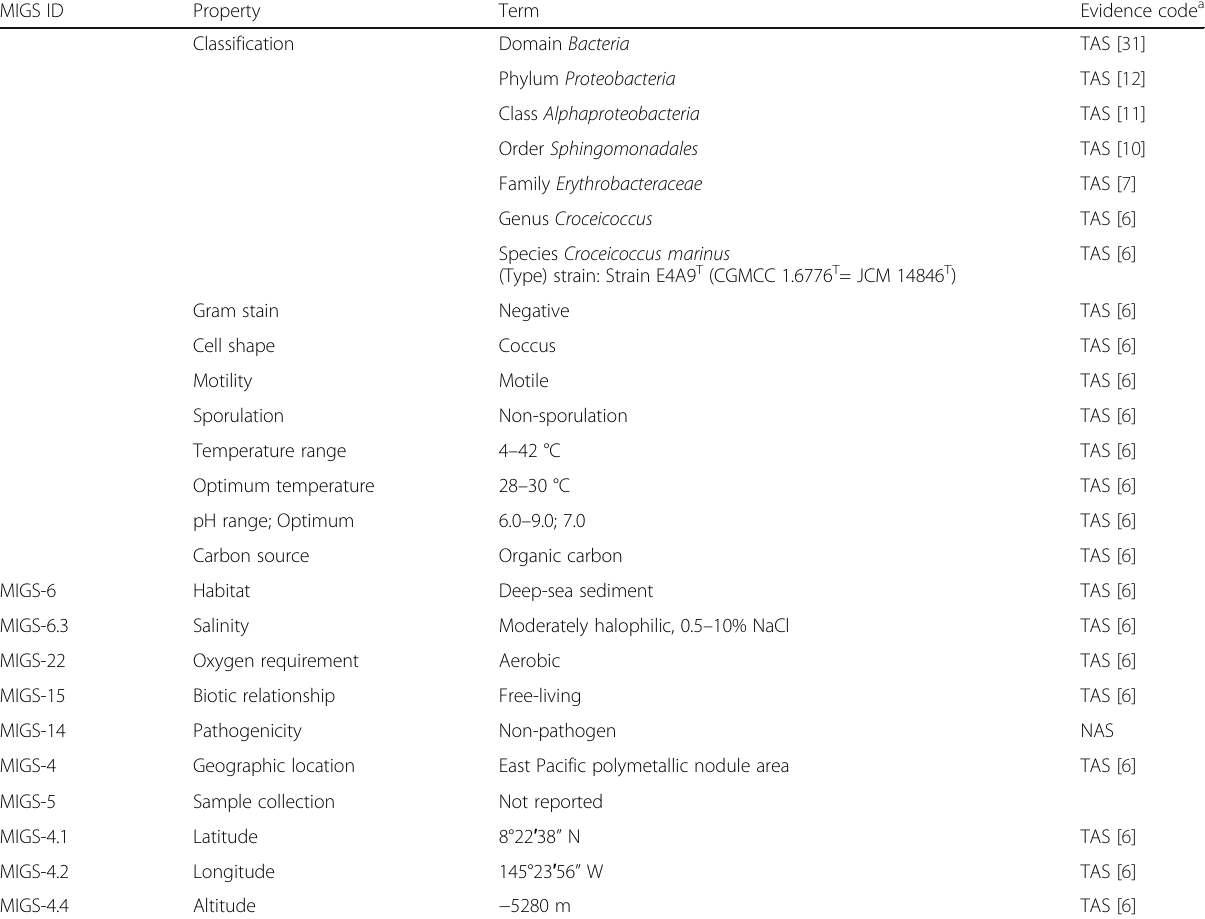
Table 1 Classification and general features of Croceicoccus marinus E4A9 T according to the MIGS recommendations [30]